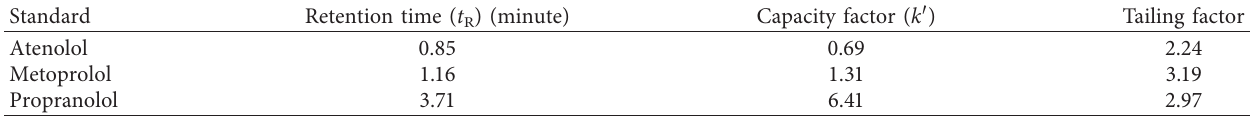
Table 3: Chromatographic profile of the imprinted monolithic column with isocratic